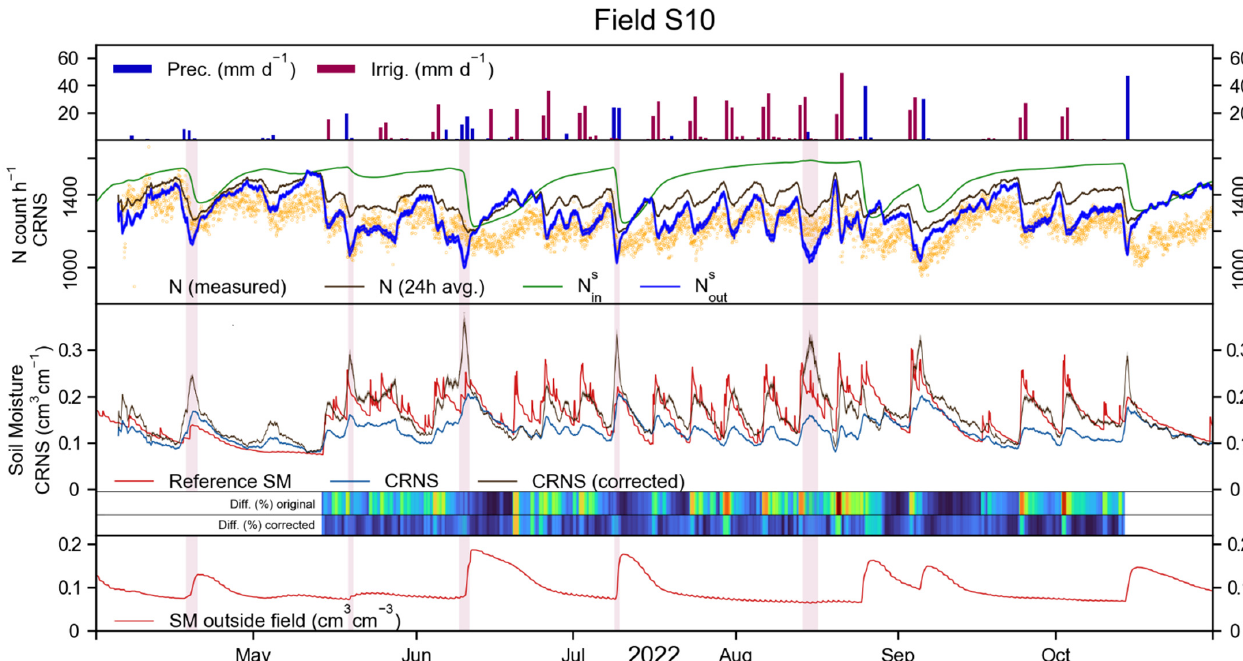
Figure 8. In the first and second panel, for field S10 during the 2022 irrigation period: precipitation, irrigation, uncorrected and corrected neutron count, and synthetic neutron counts 𝑁 (cid:3036)(cid:3041)(cid:3046) and 𝑁 (cid:3042)(cid:3048)(cid:3047)(cid:3046) . In the third panel: reference SM, standard CRNS-derived SM (blue line), and corrected CRNS-derived SM (black line). The coloured horizontal bars show the difference between CRNS and the reference SM (in % of the reference value), with blue for low difference and red for high difference. In the fourth panel: SM recorded by the sensor outside field S10.